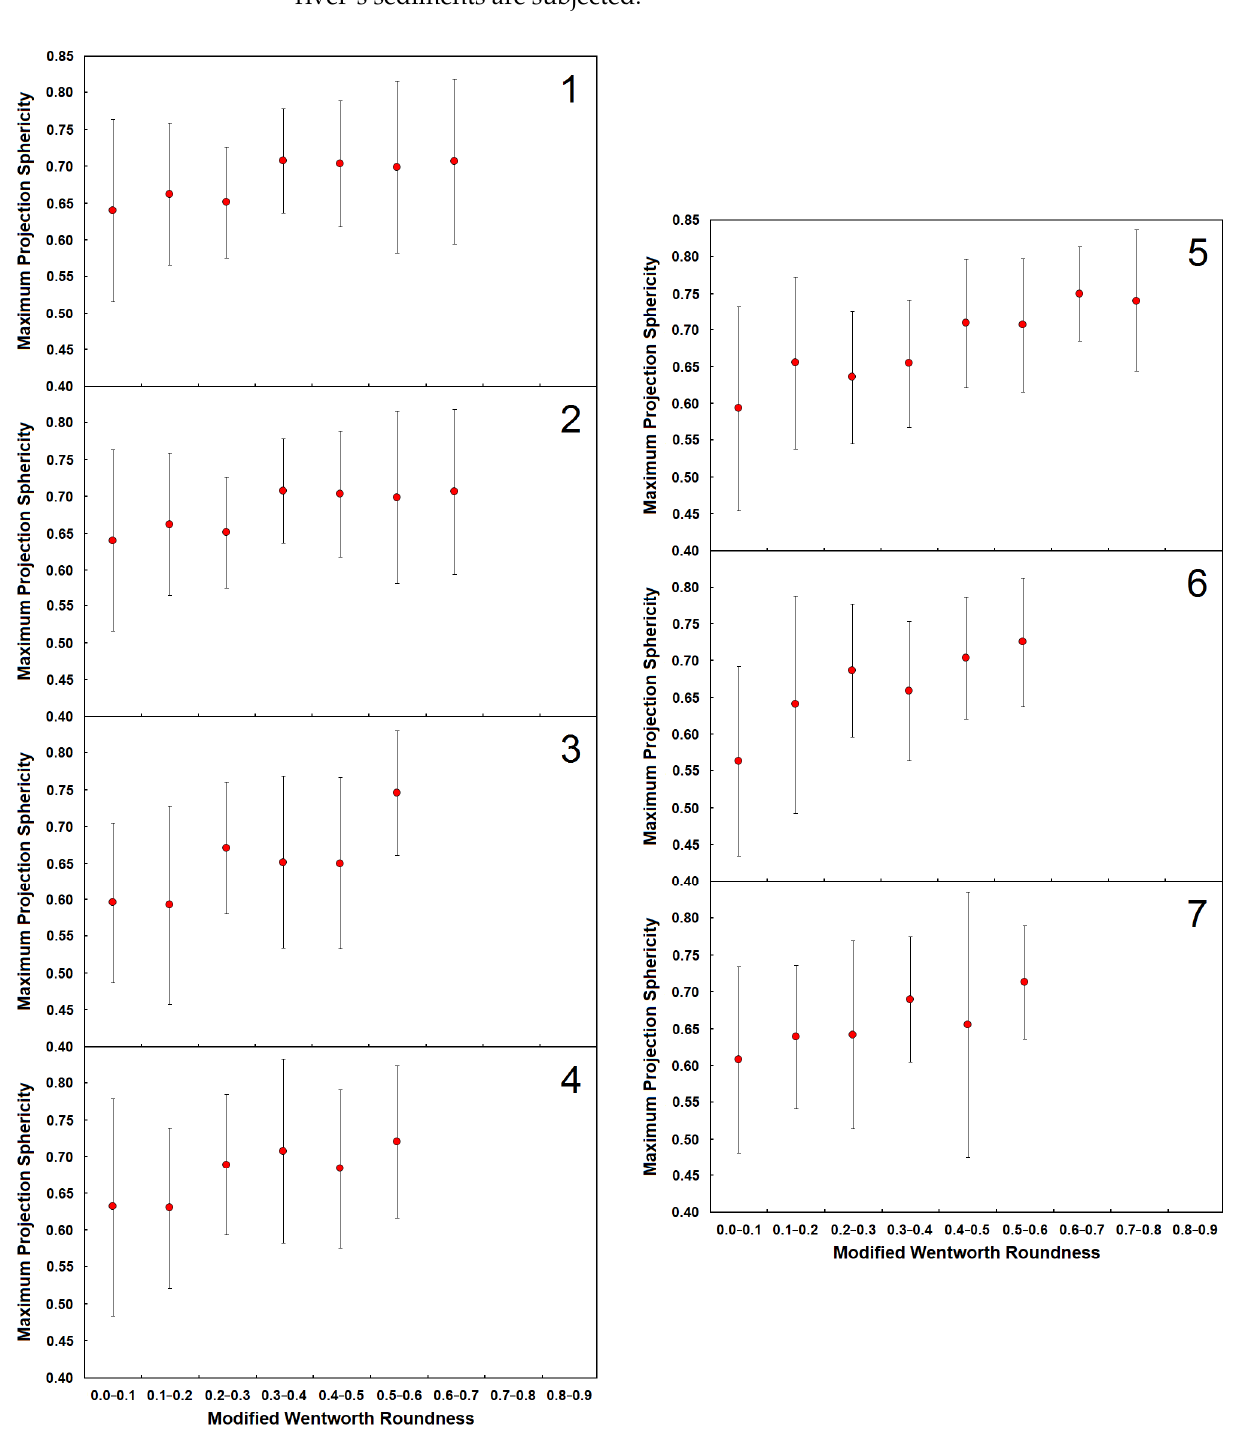
Figure 13. The Maximum Projection Sphericity of fluvial gravels of Navilawa Monzonite at Stations 1–7 along the Sabeto River of western Viti Levu, Fiji as a function of their Modified Wentworth Roundness. The data points are expressed with an uncertainty of ±1 s .